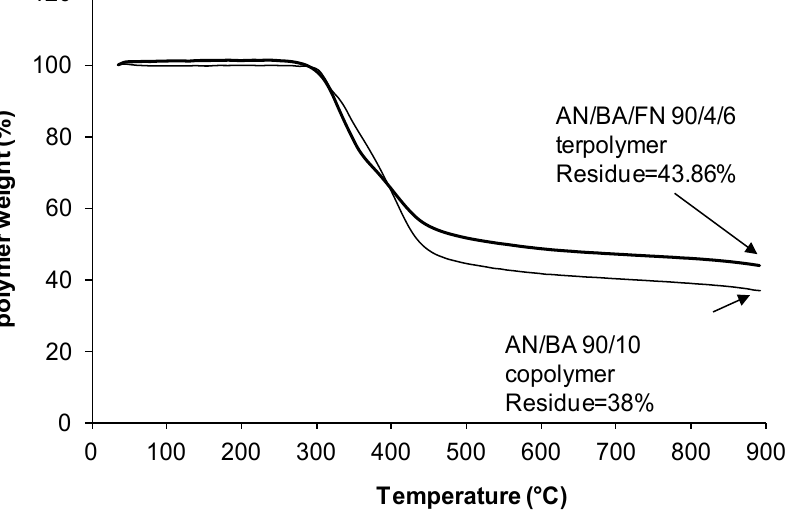
Figure 6. TGA thermograms of AN/BA 90/10 copolymer and AN/BA/FN 90/4/6 terpolymer.